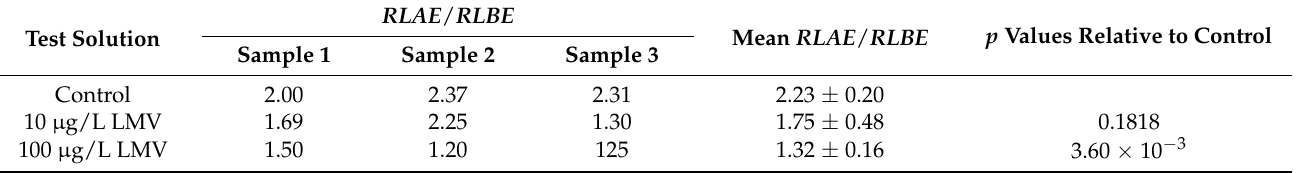
Table 1. Allium cepa root length before and after exposure to lamivudine solutions. Test Solution